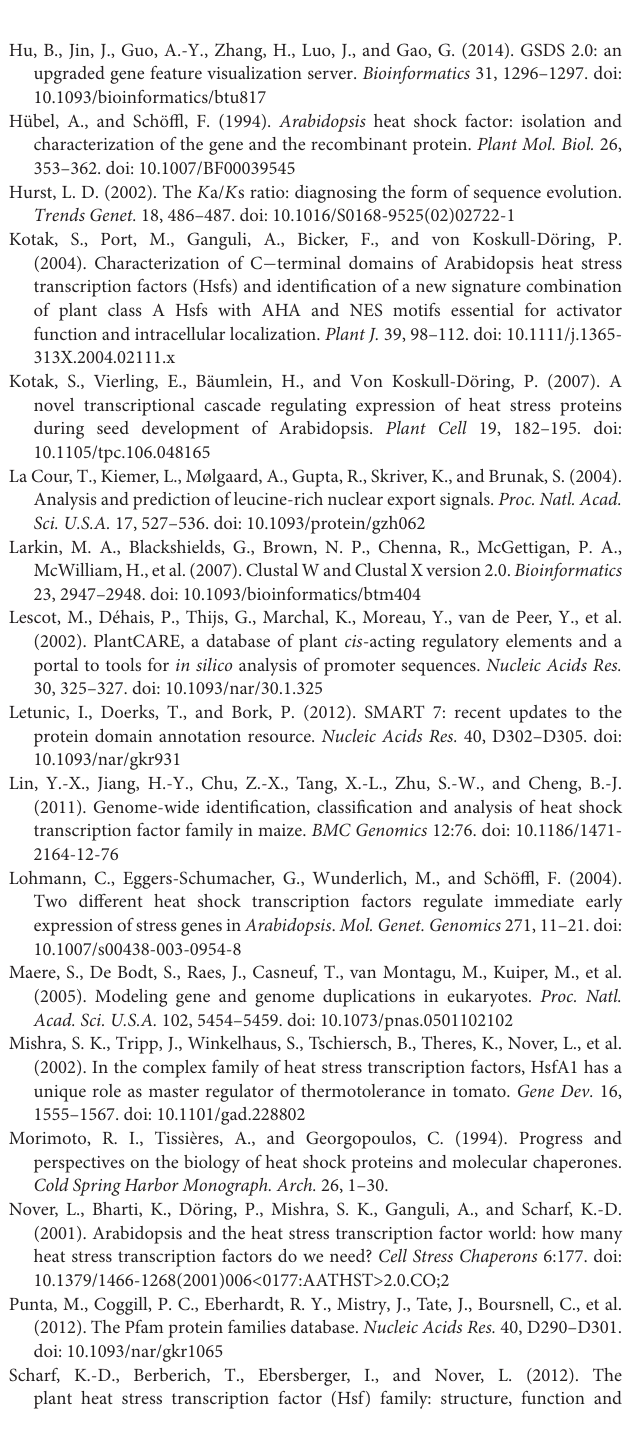
Table S1 | The complete coding sequences and the corresponding amino acid sequences of Hsf genes identified from S. suchowensis . Table S2 | Primer sequences used in experiments. Table S3 | Details of the expression data in Figure 8. The expression data correspond to log2 transformed values compared with